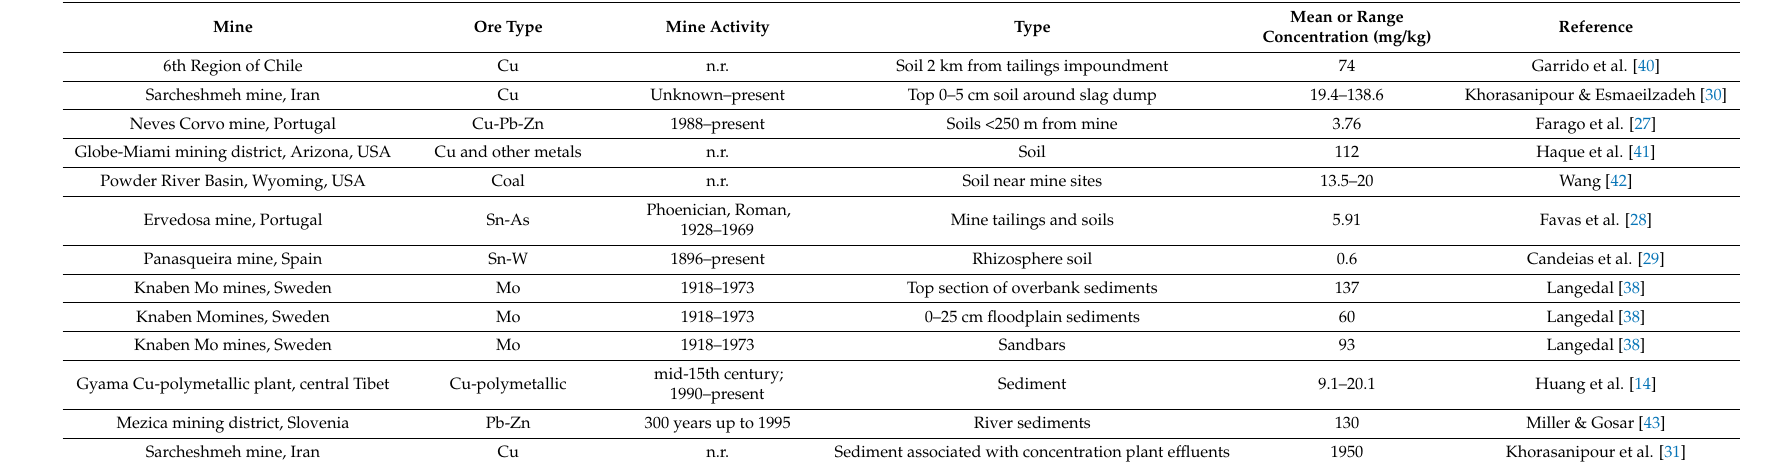
Table 3. Concentrations of Mo in mining-affected soils and sediments. n.r.: not